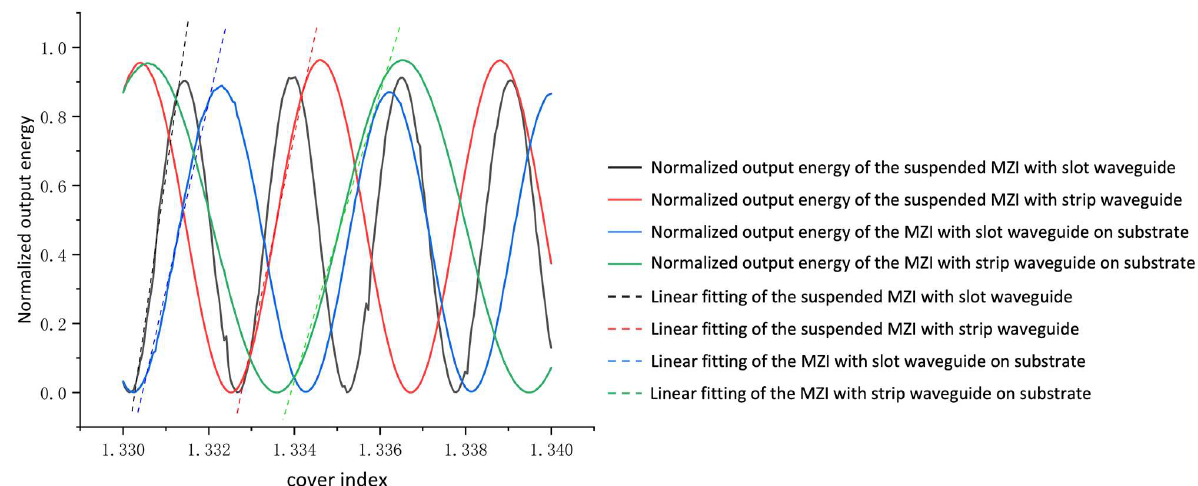
Figure 7. The connections between I out and the n c of the suspended MZI with a slot waveguide, the suspended MZI with a strip waveguide, the MZI with a slot waveguide on a substrate, and the MZI with a strip waveguide on a substrate.